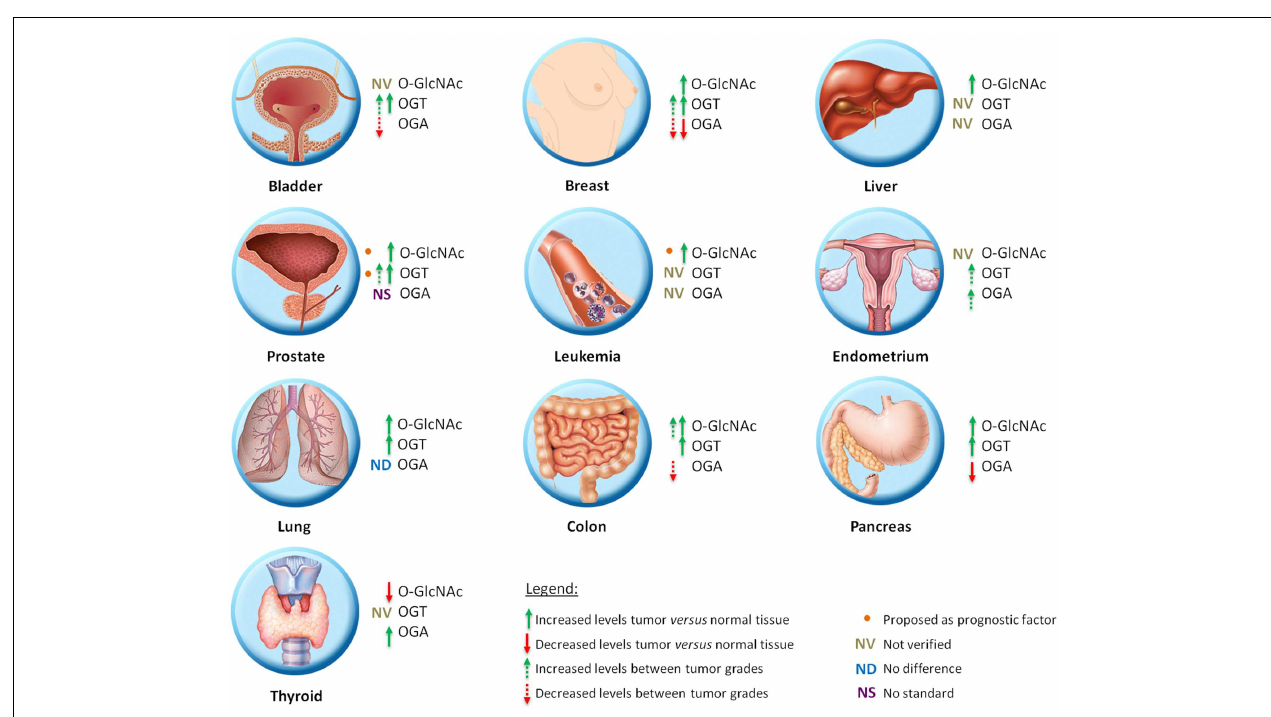
FIGURE 2 | Schematic representation of O -GlcNAc dynamics in different types of tumor